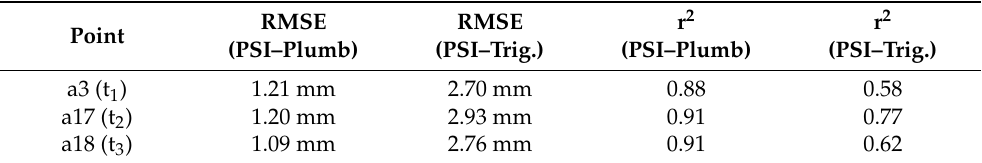
Table 5. Accuracy measures for the three presented PS points in Figure 5. PSI measurements are compared to in situ measurements utilizing the RMSE and r 2 , respectively.